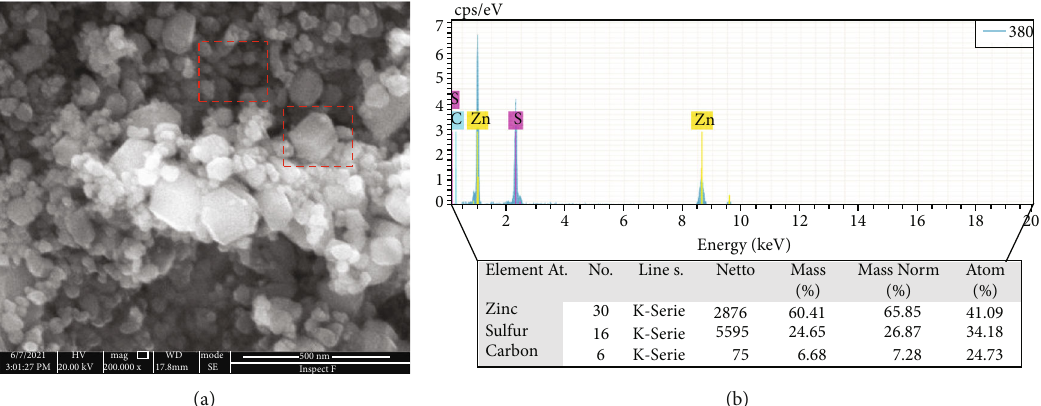
Figure 1: (a) SEM image of the ZnS materials at the sulfurization temperature of 350 ° C and (b) the corresponding EDX spectra.